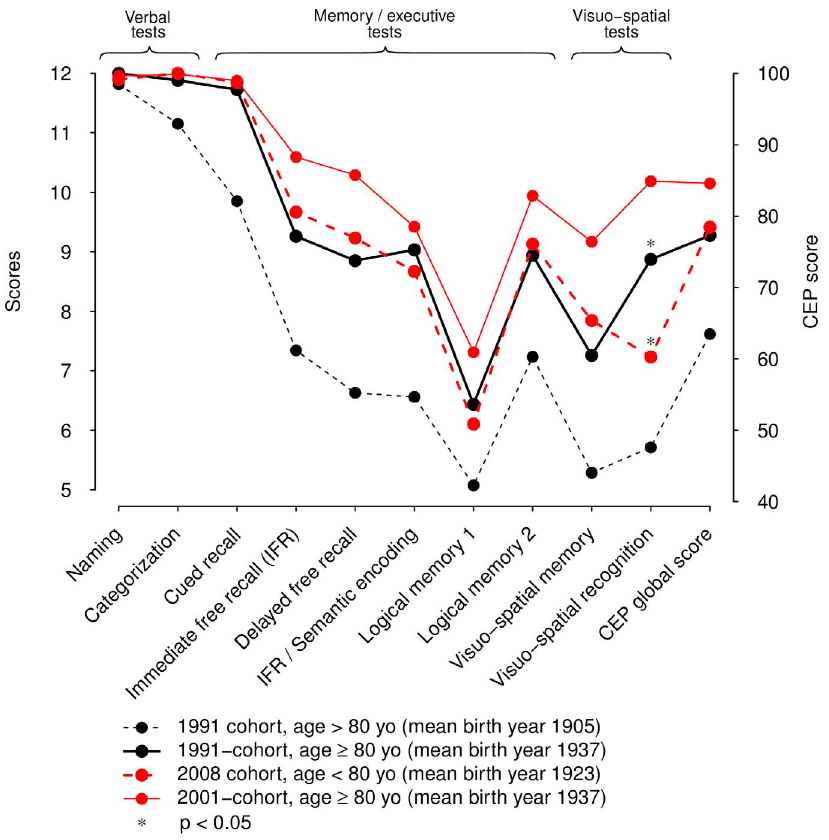
Figure 3. Comparison according to age and birth date in the 1991-and 2008-samples.